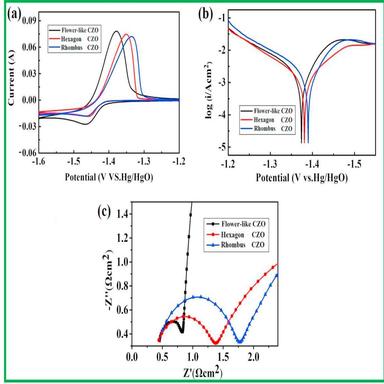
(a) Cyclic voltammograms of the three calcium zincate electrodes at a scan rate of 10 mV s1 ; (b) Tafel plot curves and (c) Nyquist plots of the three calcium zincate electrodes.